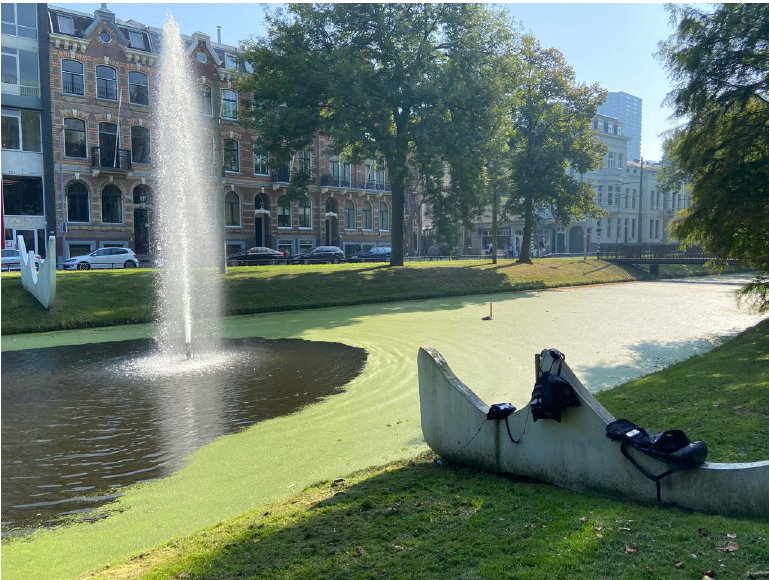
Figure 11: Lemna gibba. Collecting Lemna gibba (duckweed) for experiments. (51.9136808, 4.4757090).